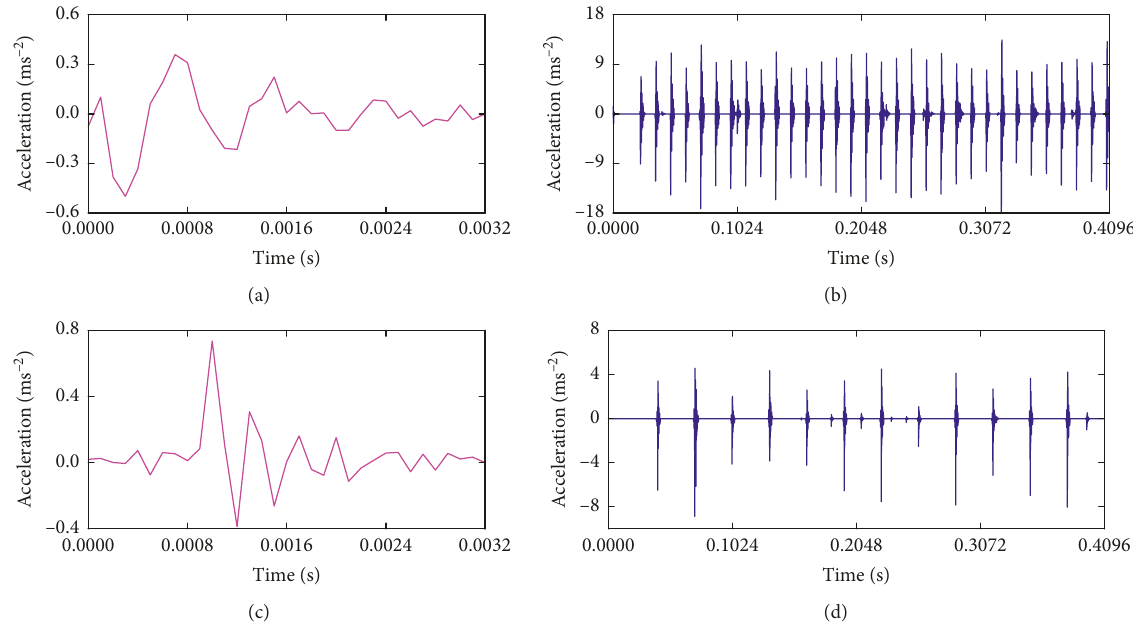
Figure 17: IRSs extracted using ACSR: (a) learned impulse response 1; (b) extracted IRS1; (c) learned impulse response 2; (d) extracted IRS2.